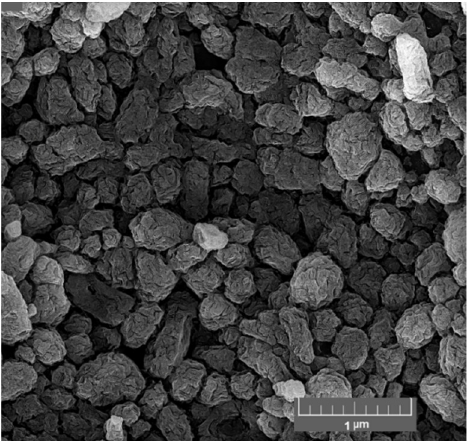
Figure 3. FE-SEM image of chitosan nanoparticles (CSNPs). (3 mg/mL of CS, 1 mg/mL of STPP, and a CS to STPP ratio of 3:1).